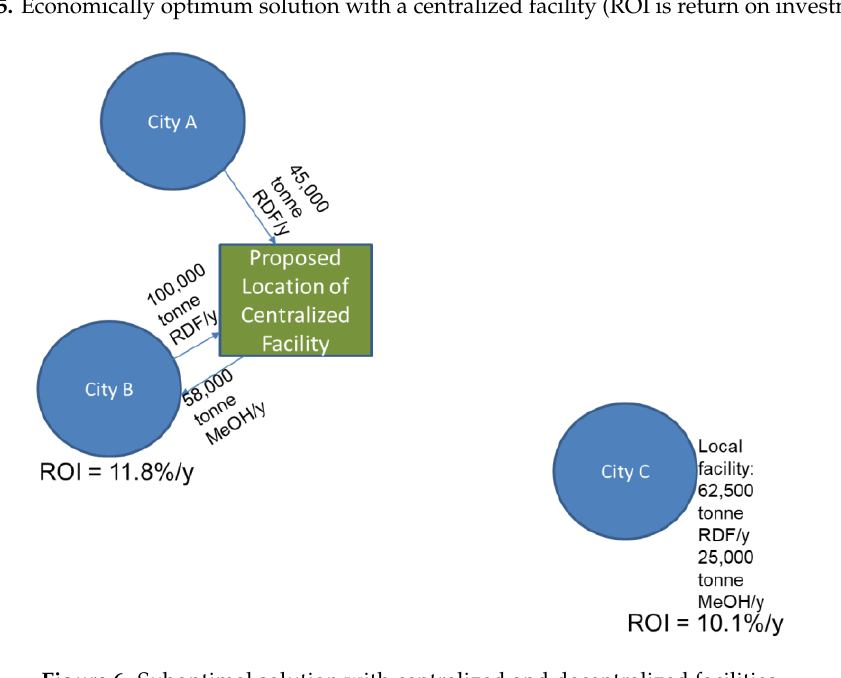
Figure 6. Suboptimal solution with centralized and decentralized facilities.